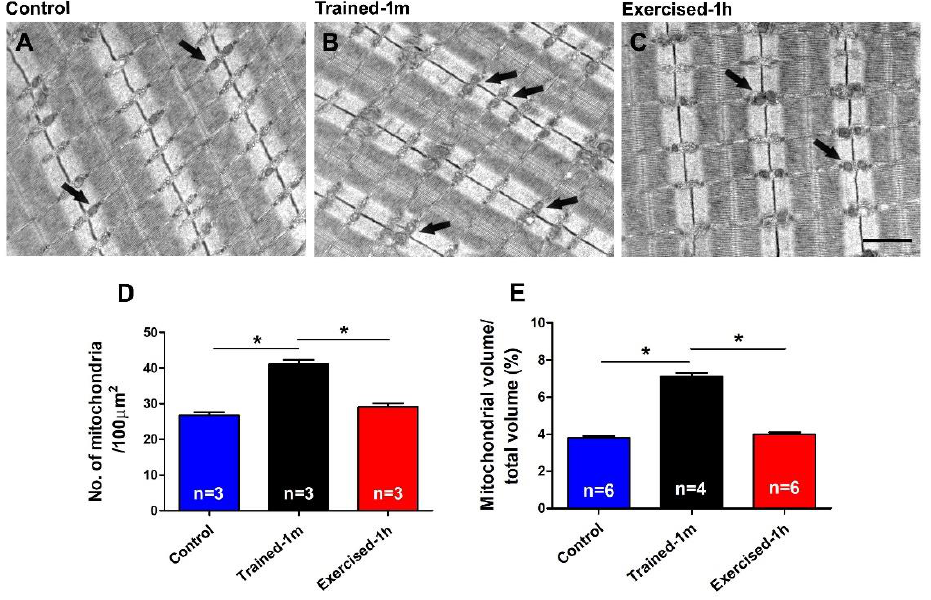
Figure 5. Electron-micrographs and quantitative analysis of mitochondria: ( A – C ) Representative EM images showing mitochondria distribution in longitudinal EDL sections (some mitochondria are pointed by arrows); ( D , E ) bar graphs showing the quantitative analysis of mitochondria number/area and relative fiber volume occupied by them, respectively. Data are shown as mean ± SEM (* p < 0.05; the two ends of the line with asterisk indicate which two groups are being compared). Note, n = number of EDL analyzed. Scale bar: ( A – C ) = 1 µ m. See also Supplementary Table S4.